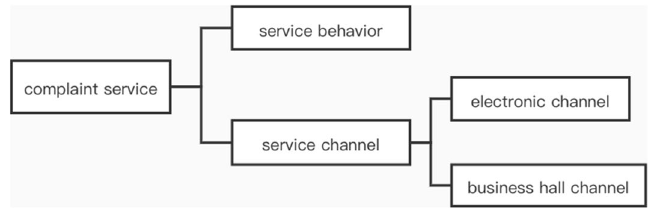
Figure 1. Example of the hierarchy of a customer